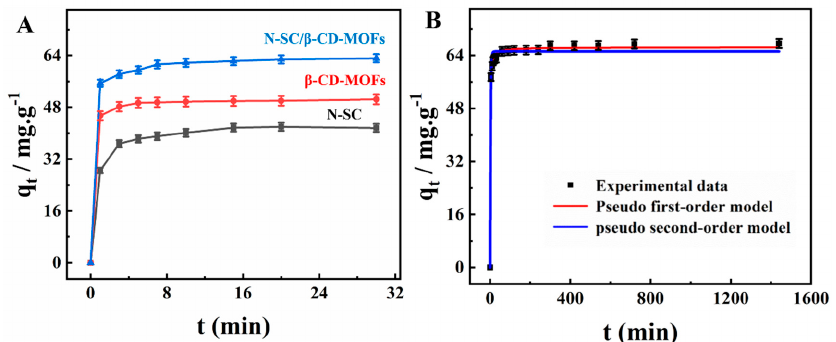
Figure 3. ( A ) Adsorption kinetic curves of AC on N-SC, β -CD-MOFs, and N-SC/ β -CD-MOFs; ( B ) Adsorption kinetics curves of AC on N-SC/ β -CD-MOFs. Table 1. Kinetic parameters for AC adsorption onto N-SC/ β -CD-MOFs. Pseudo First-Order Model